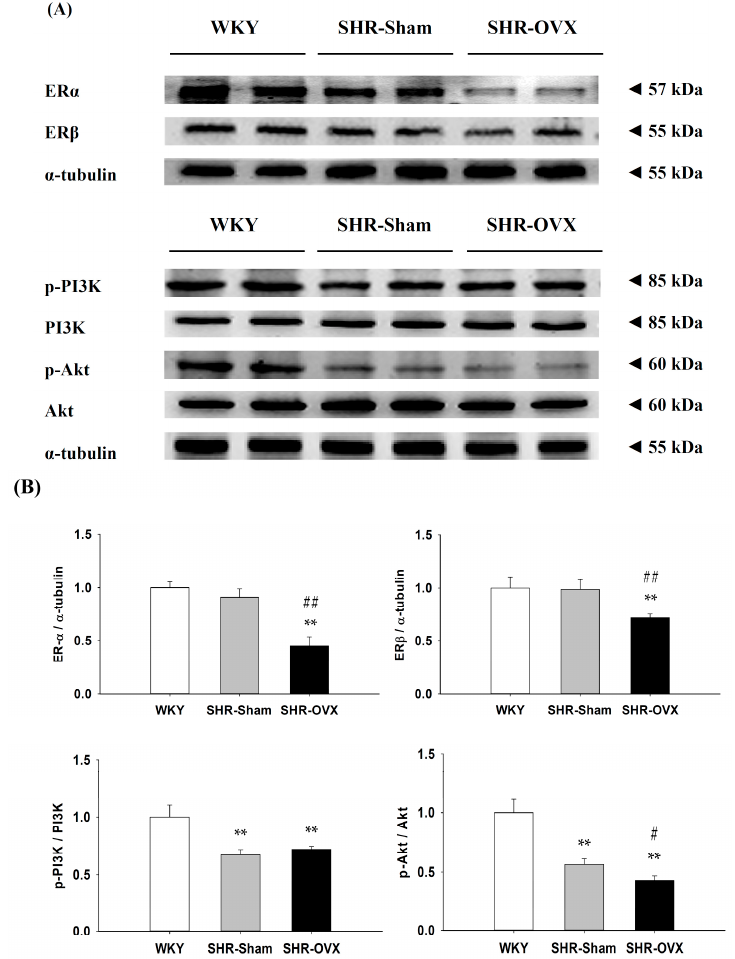
Figure 2. ( A ) The two representative protein products of estrogen receptor α (ER α ) and estrogen receptor β (ER β ), p-PI3K, PI3K, p-Akt and Akt extracted from the left ventricles of excised hearts from the Wistar Kyoto rats (WKY), SHR with sham-operated (SHR-Sham) and SHR with bilateral ovariectomized (SHR-OVX) were measured by Western blot analysis; ( B ) The bars represent the relative protein quantification of ER α , ER β , p-PI3K/PI3K and p-Akt/Akt on the basis of α -tubulin and the average protein expression levels in the WKY group normalized to one, and then, a relative protein expression was calculated for each condition. Data presented as the mean values ± SD ( n = 8 in each group); ** p < 0.01 denotes significant differences from the WKY group; # p < 0.05, ## p < 0.01 denote significant differences from the SHR-OVX